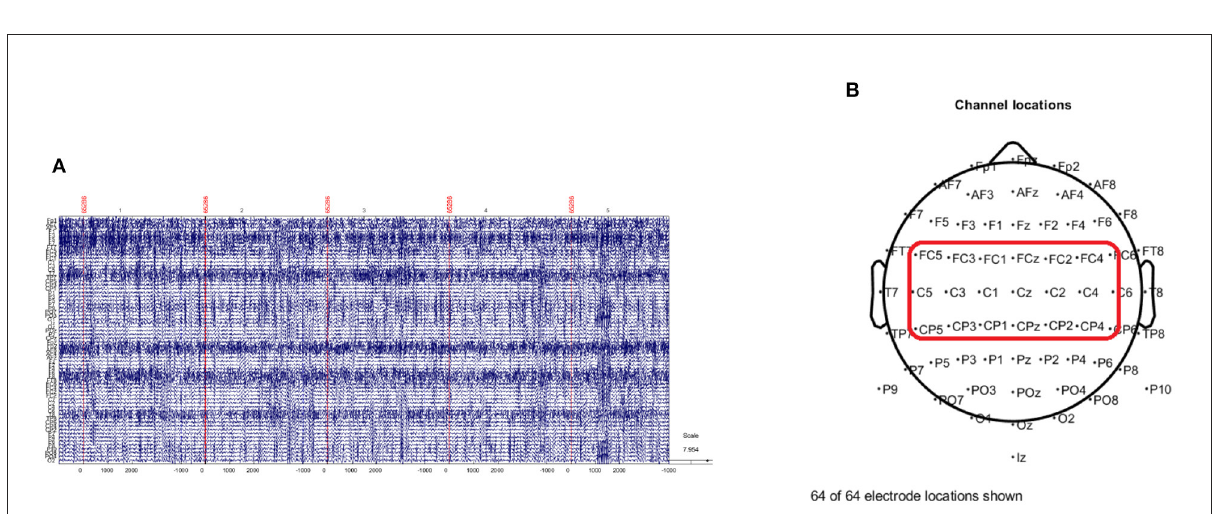
FIGURE2 The preprocessing of EEG signal. (A) Illustrates the EEG imagery epochs extracted from preprocessed (band pass filter and common average reference) EEG signal. (B) Shows the standard 10–20 electrode layout of the 64-channel EEG sensor. Twenty-one channels in the red rectangular area are selected for further